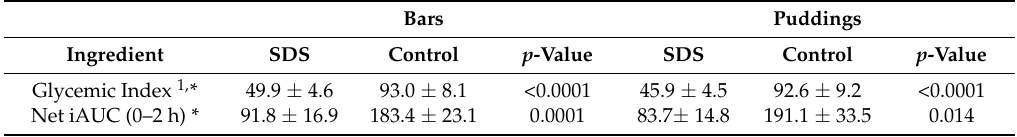
Table 4. Glycemic index and net incremental area-under-curve (iAUC) for SDS and control.